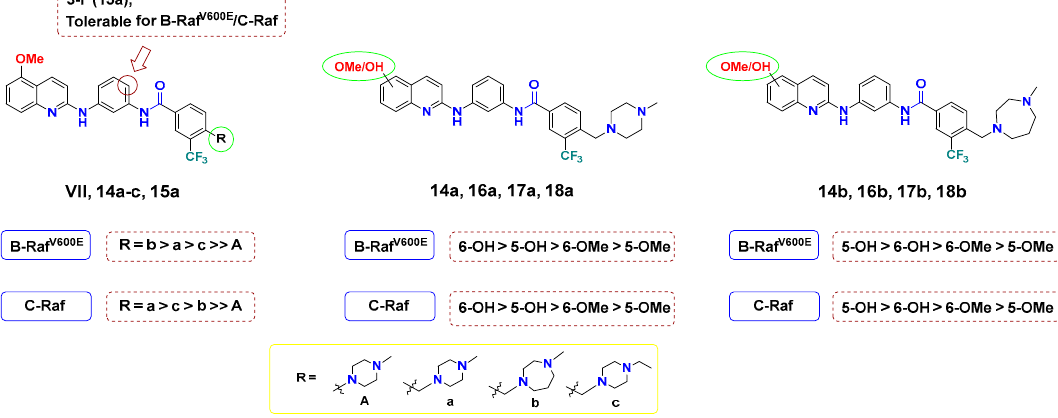
Figure 4. SAR analysis of final compounds 14a – c , 15a , 16a , b , 17a , b and 18a , b for B-RAF V600E /C-RAF.